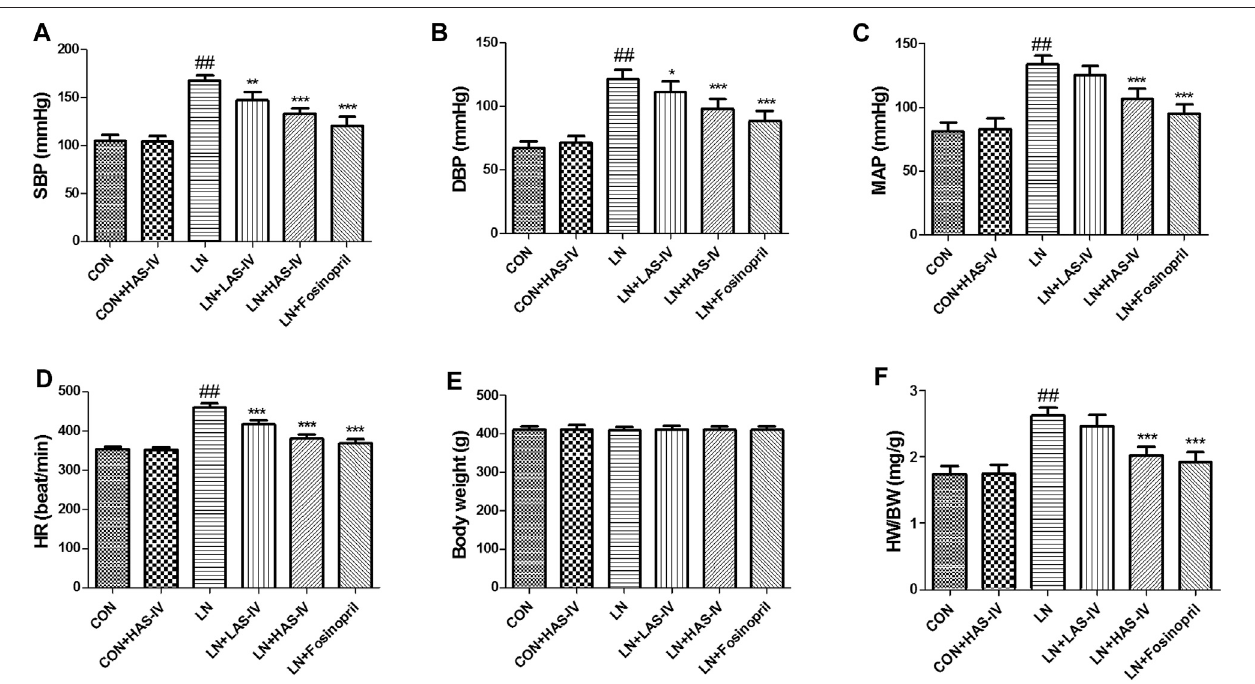
FIGURE3| EffectsofAstragalosideIV(AS-IV)oncardiovascularparametersinL-NAME-treatedrats.TheSBP (A) ,DBP (B) ,MAP (C) ,HR (D) ,bodyweight (C) ,and HW/BW (F) was measured at the end of experiment. Results were showed as mean ± SD ( n (cid:1) 6 for each group). ## p < 0.001 versus CON group; * p < 0.01 versus LN group; ** p < 0.01 versus LN group; *** p < 0.001 versus LN